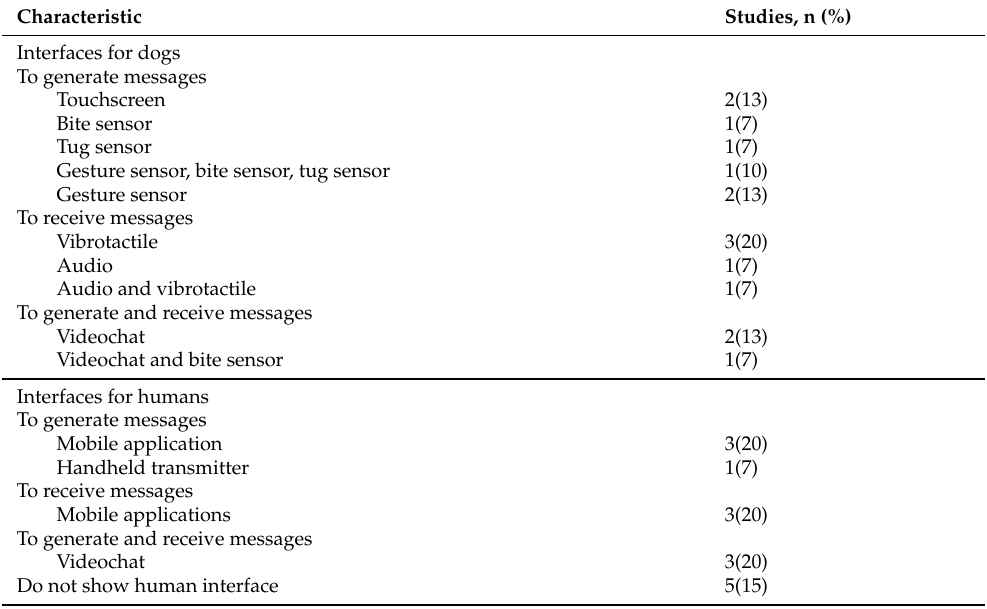
Table 1. Overview of the main characteristics of the reviewed technology (n =